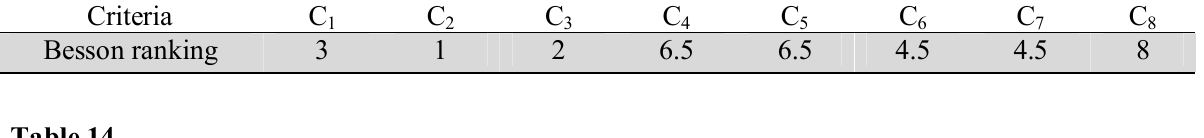
Besson ranking of the alternatives in ORESTE method Criteria FMS1